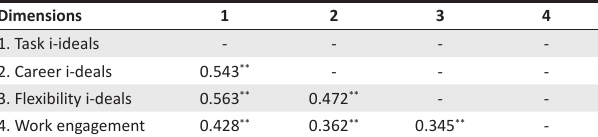
TABLE 2: Correlation analysis for idiosyncratic deals and work engagement. Dimensions 1